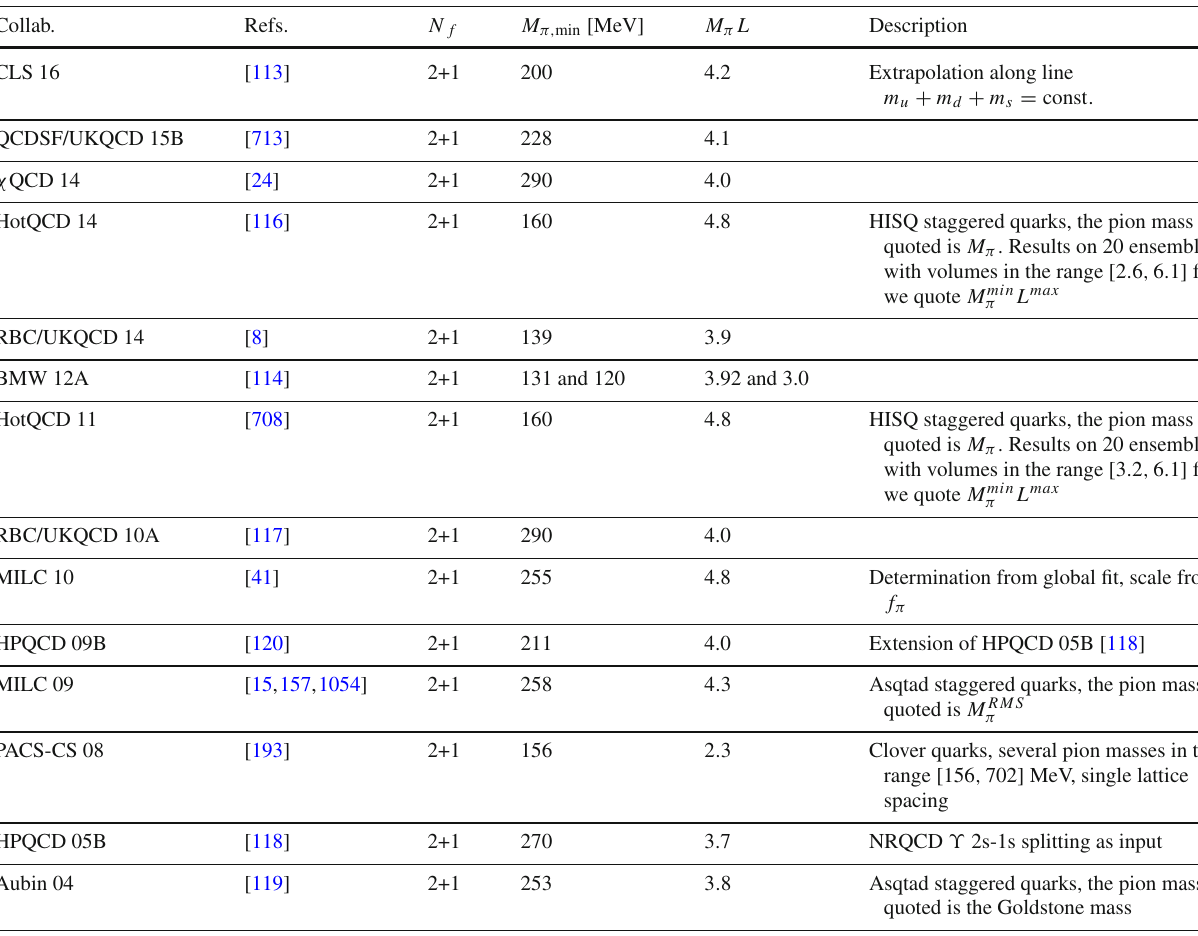
Table 200 Chiral extrapolation and finite-volume effects in scale determinations with N f = 2 + 1 quark flavours. We list the minimum pion mass M π, min and M π L ≡ M π, min [ L ( M π, min ) ] max is evaluated at the maximum value of L available at M π = M π, min